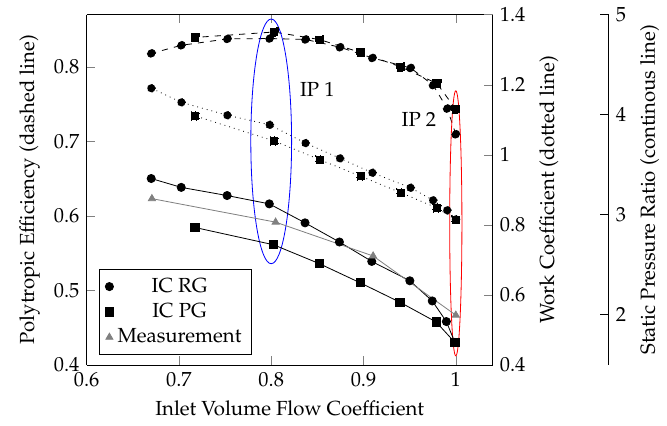
Figure 11. Performance Map: Real Gas (RG) vs. Perfect Gas (PG)